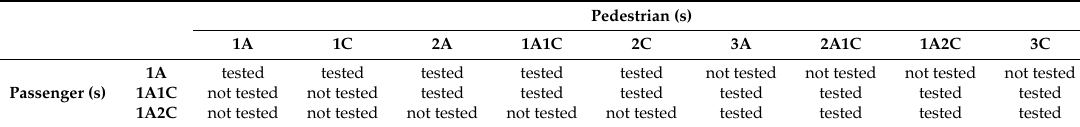
Table 1. The 16 forced-choice scenarios (A = Adult, C = Child). Pedestrian